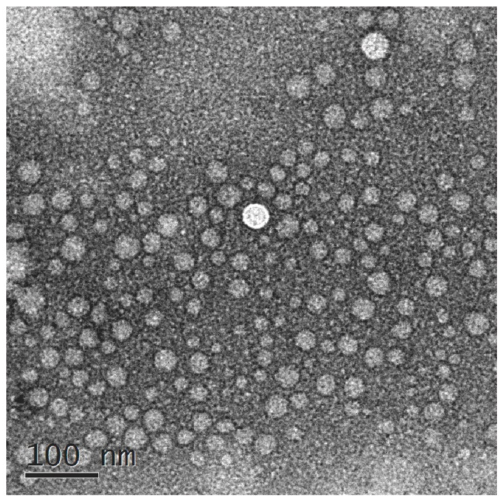
Figure 1. TEM images of